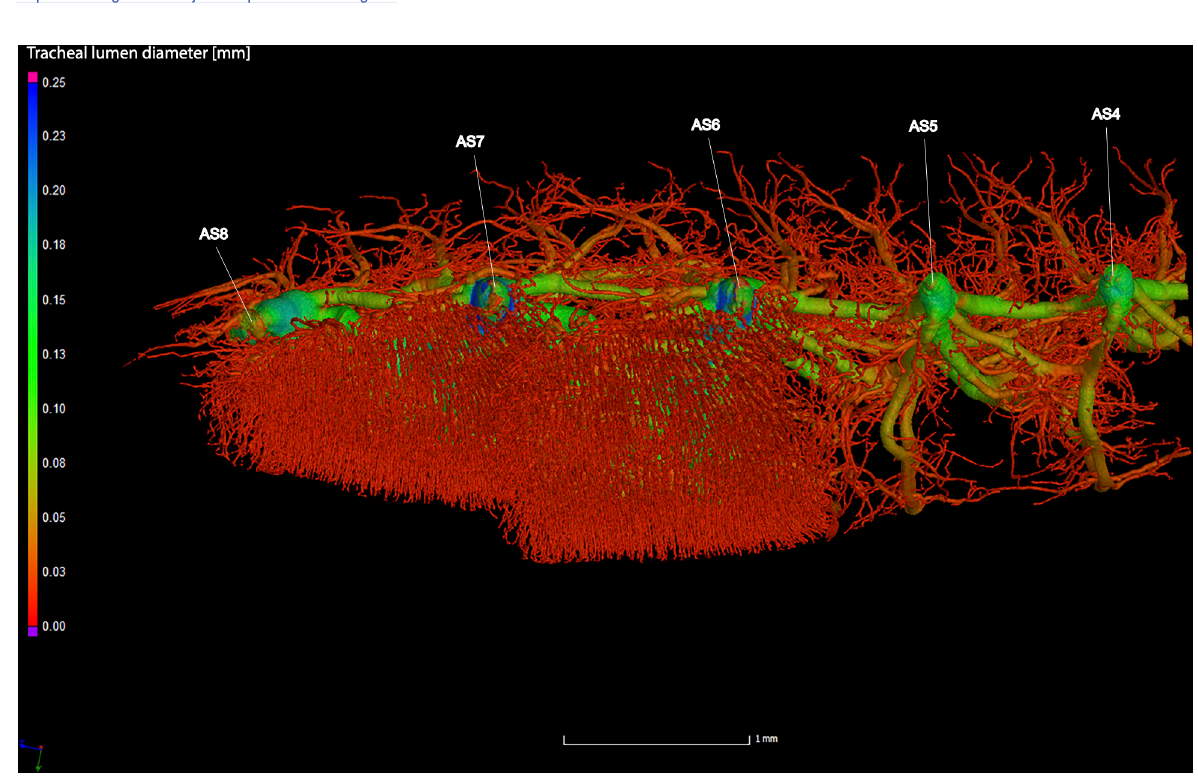
Fig 10. Lateral view of the abdominal tracheal system in adult male Photinus pyralis . https://doi.org/10.1371/journal.pone.0268112.g010 PLOS ONE | https://doi.org/10.1371/journal.pone.0268112 June 1,